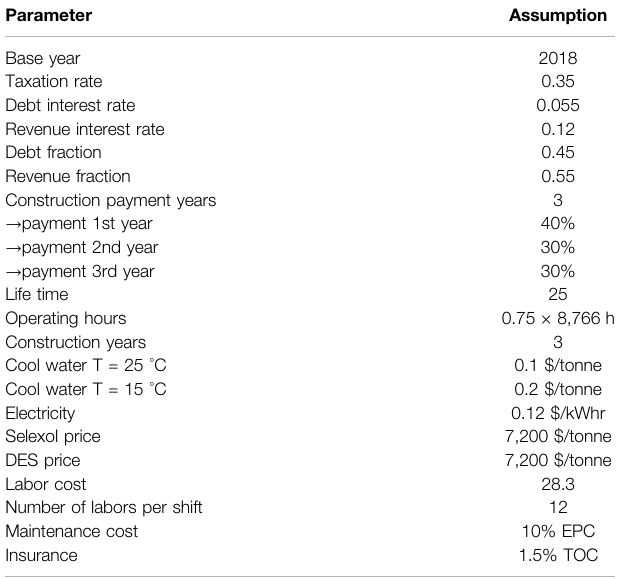
TABLE 7 | Main assumptions for the economic analysis.